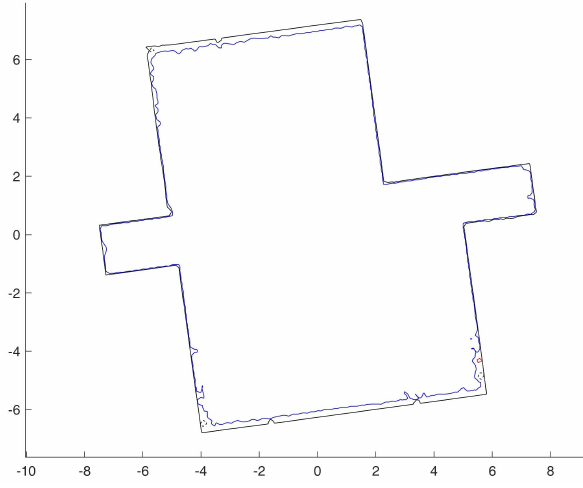
Figure 9: Boundary polygonal chains for the input point